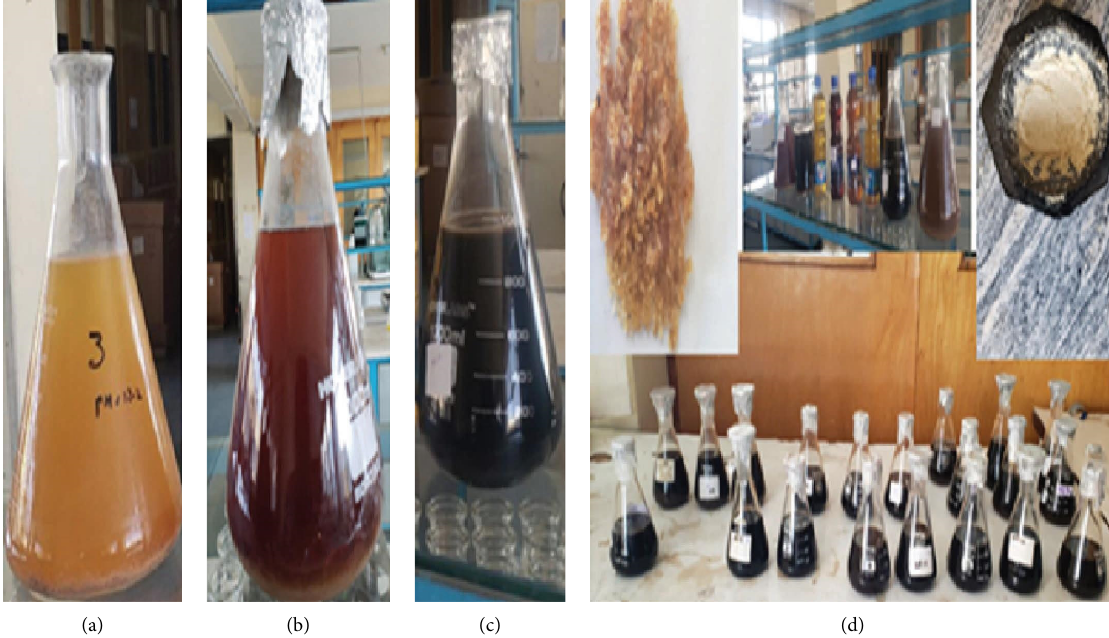
Figure 2: Extraction products: (a) white sheep hair, (b) red sheep hair, (c) mixed sheep hair, and (d) powder